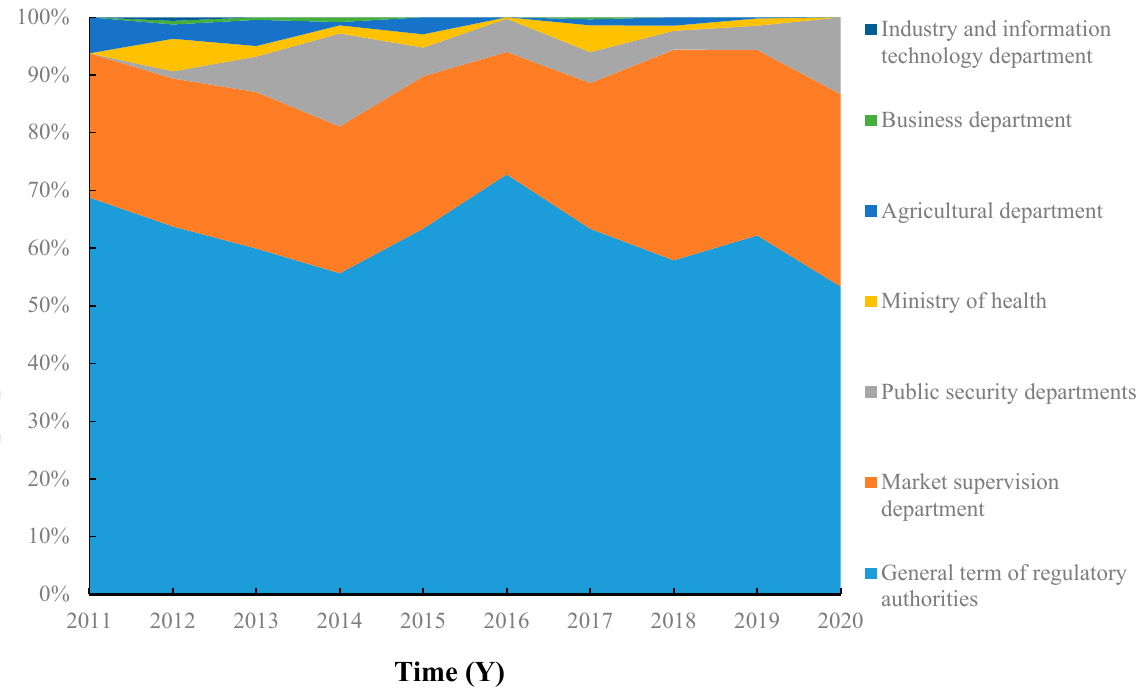
Figure 4. Trend of consumer’s emotion about additive issues from 2011 to 2020.